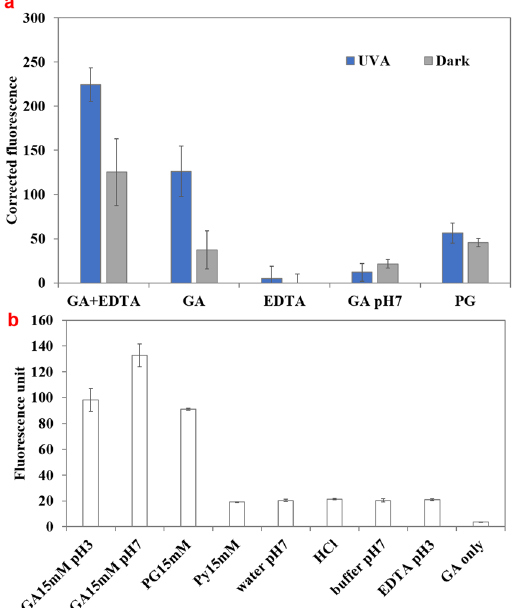
Figure 2. Measurement of uptake of gallic acid (GA) and its derivatives in E. coli O157:H7 as measured by binding with DPBA. ( a ) E. coli O157:H7 treated by GA (15 mM) + EDTA (1 mM) solution, GA (15 mM), EDTA (1 mM), GA in phosphate buffer solution (100 mM, pH 7.4), or PG (10 mM) in the presence and absence of UV-A light. Absolute fluorescence values were corrected by subtracting the fluorescence values for samples incubated in water and in dark. ( b ) The assessment of DPBA sensitivity to binding various compounds in the absence of bacteria. Mean ±